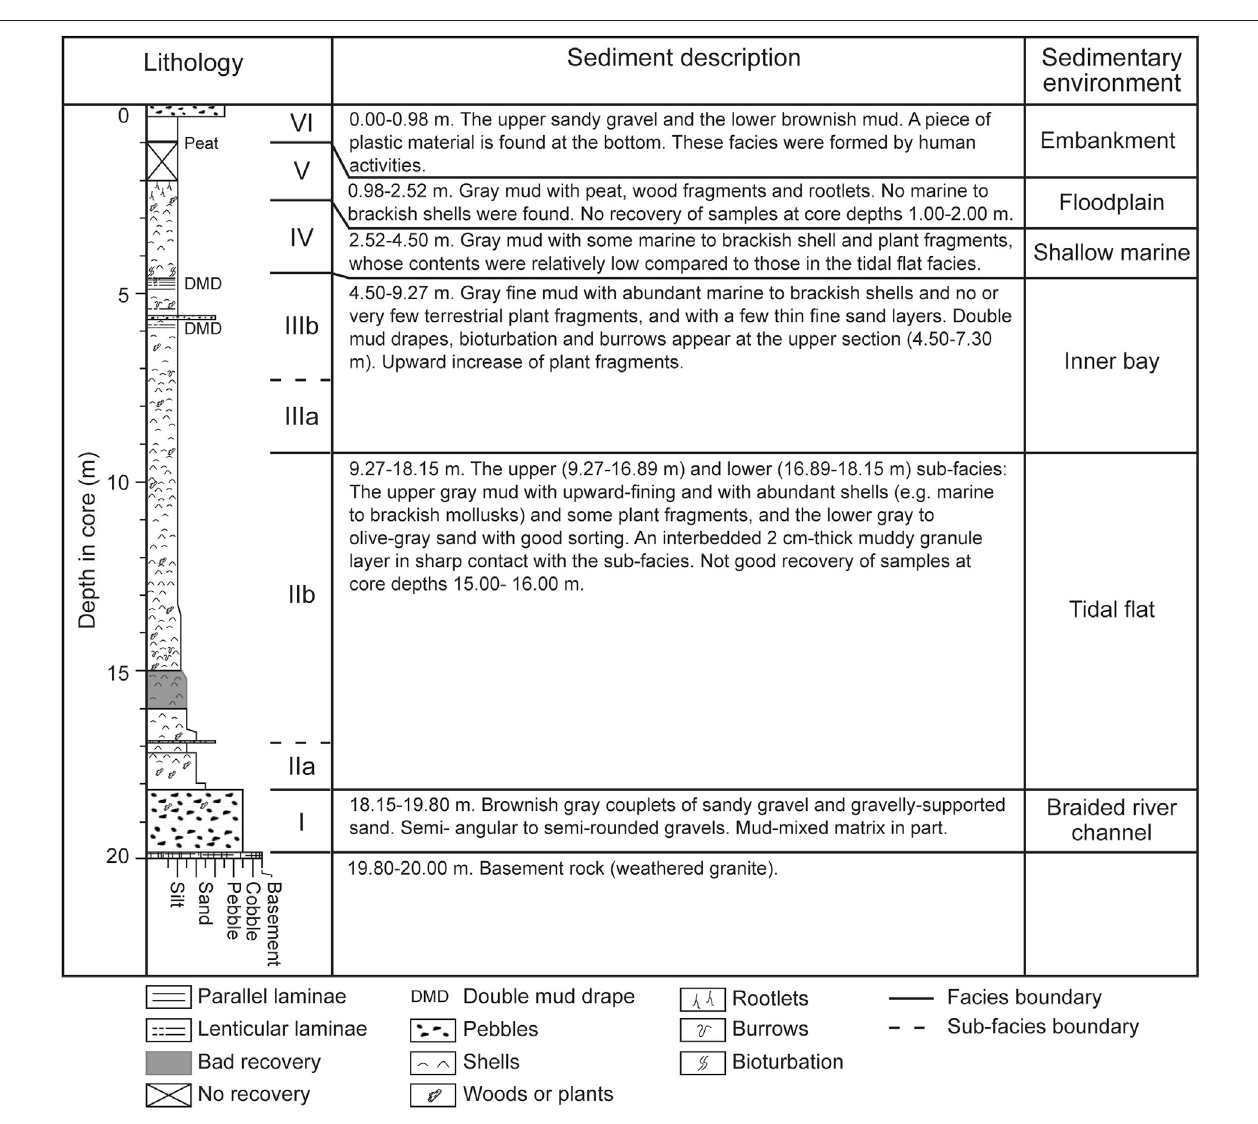
FIGURE2| SummaryofsedimentarycharacteristicsoftheYAR04coredocumentedbyNakanishietal.(2013),showingcolumnarlithology,sedimentdescriptions and inferred sedimentary environments.